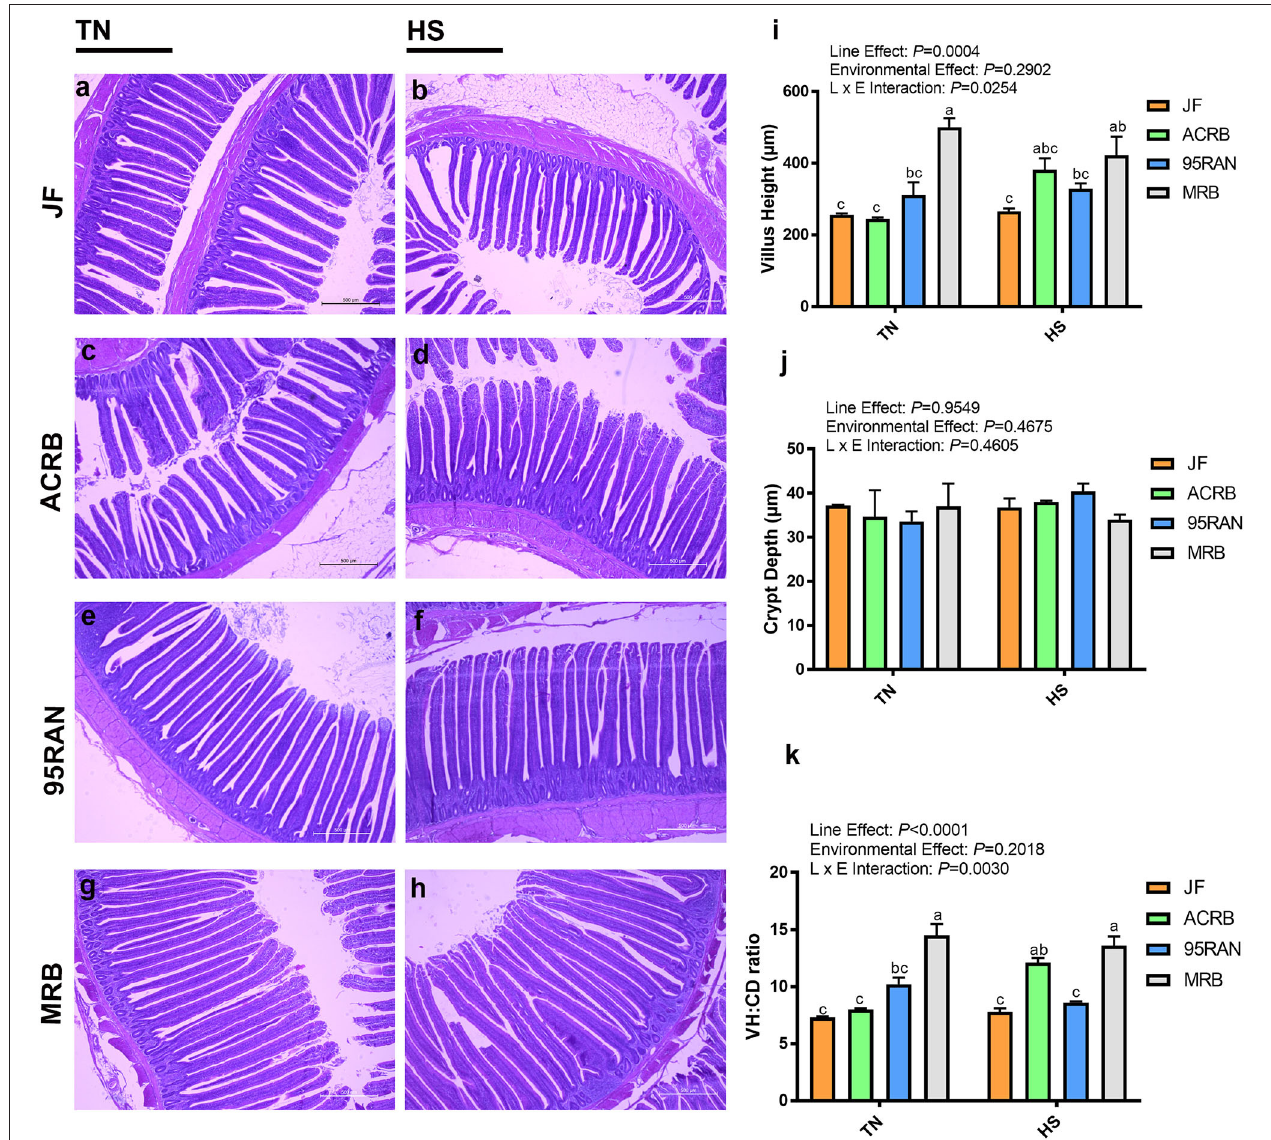
FIGURE 2 | Effect of HS on intestinal morphology of JF (a,b) , ACRB (c,d) , 95RAN (e,f) , and MRB (g,h) birds. Tissue from the jejunum of TN (a,c,e,g) and HS (b,d,f,h) birds were processed and stained for histology. Data are mean ± SEM ( n = 2/group). VH (i) , CD (j) , and VH:CD ratio (k) were measured and analyzed. Different letters indicate the significant difference at P < 0.05. VH, villus height; CD, crypt depth; HS, heat stress; TN, thermoneutral; JF, jungle fowl; ACRB, Athens Canadian Random Bred; 95RAN, 1995 random bred; MRB, modern random bred.